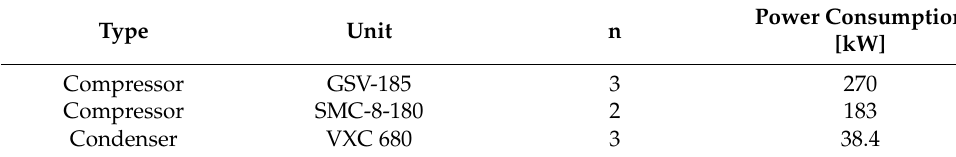
Table 4. Refrigeration units and power consumption.